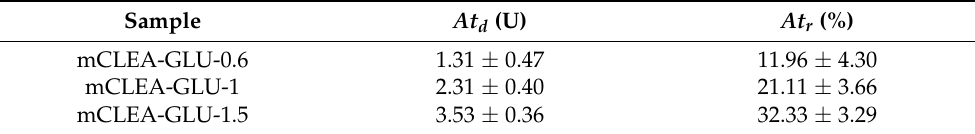
Table 1. Effect of different glutaraldehyde concentrations on magnetic cross-linked enzyme aggre- gates (mCLEAs) parameters of β -galactosidase: Immobilized enzyme activity ( At d ) and Recovered activity ( At r ).